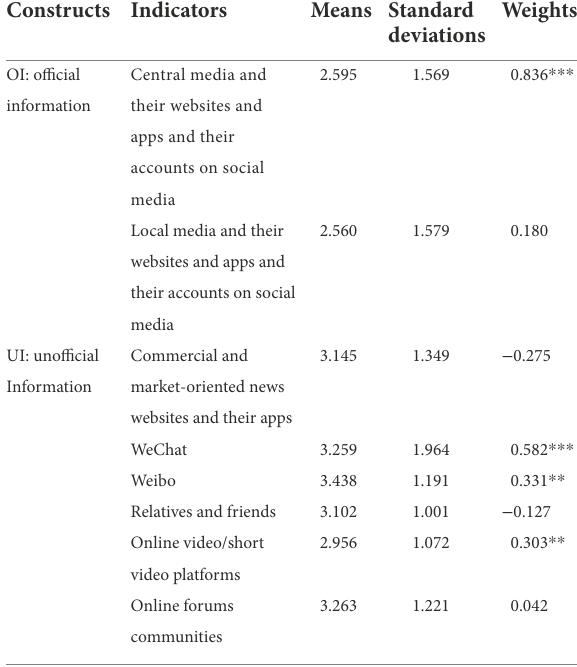
TABLE 3 Loads and cross-loads of reflective variables.